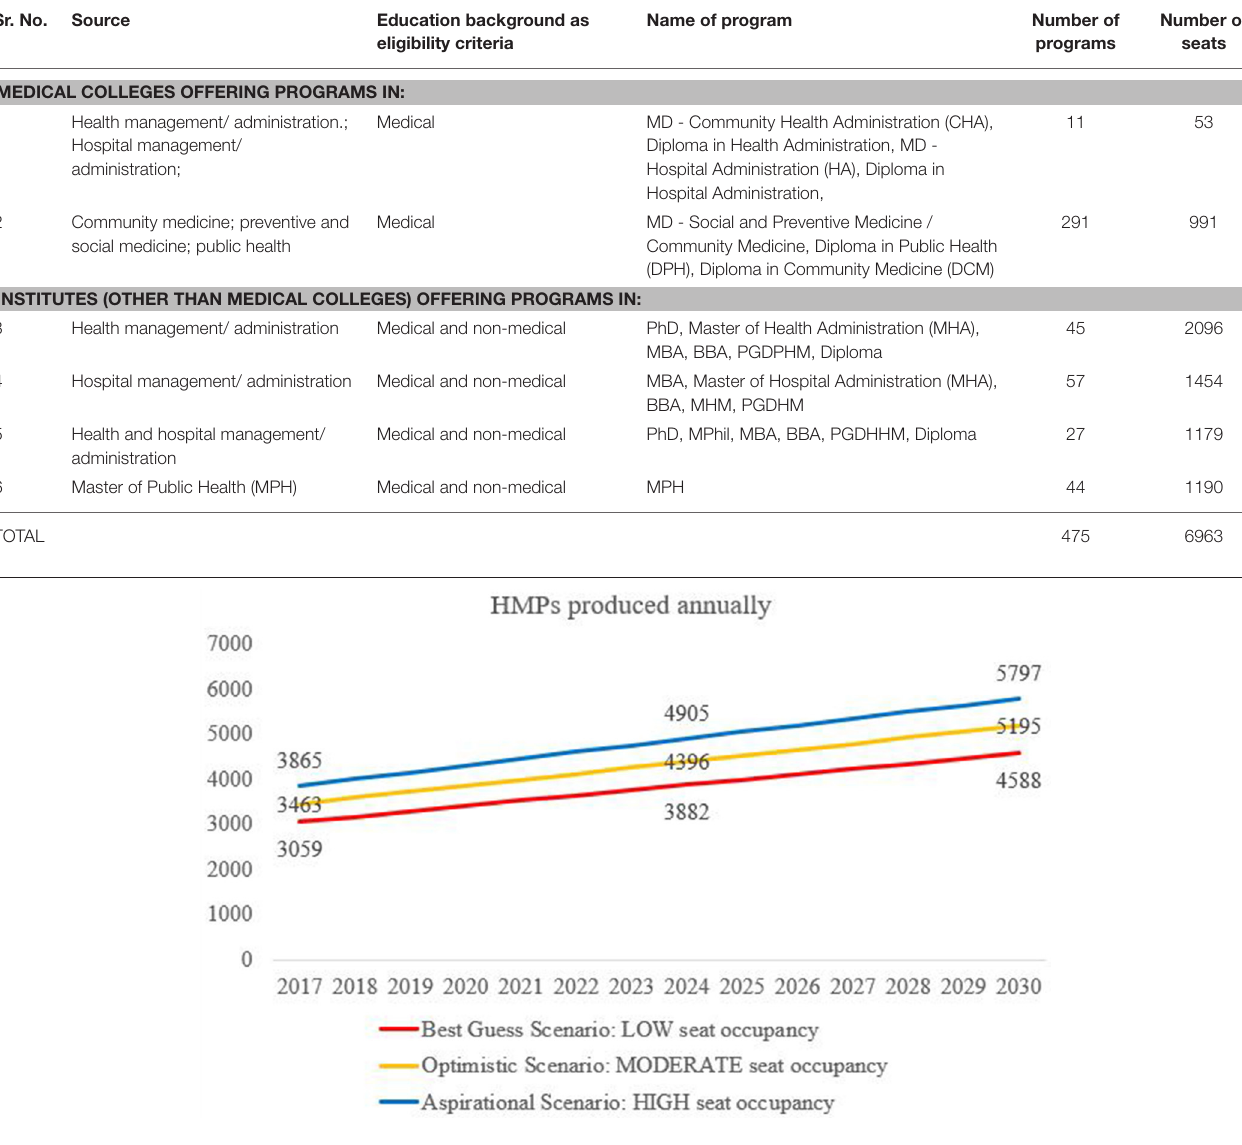
FIGURE 1 | Health Management Professionals HMPs produced annually in Best Guess, Optimistic and Aspirational scenarios in India (2017 to